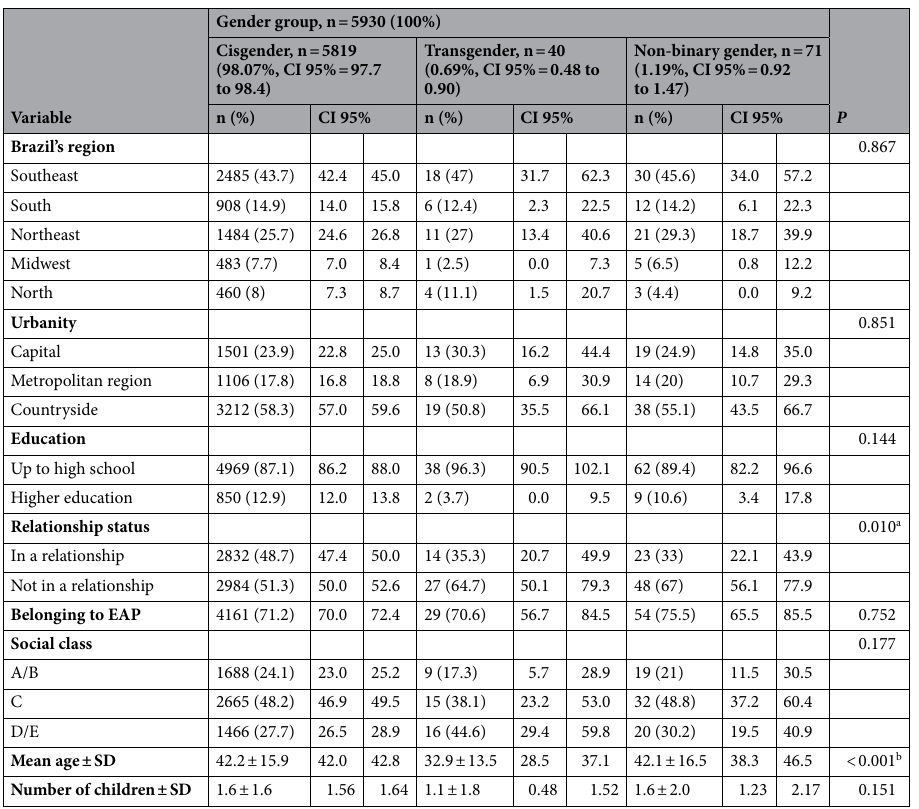
Table 1. Weighted sociodemographic characteristics of each gender identity group (cisgender, transgender, and non-binary gender). CI = confidence interval. All percentages and CIs were design-adjusted. EAP = economically active population. SD = standard deviation. a Cisgender group ≠ non-binary gender group. b Cisgender and non-binary gender groups ≠ transgender group.